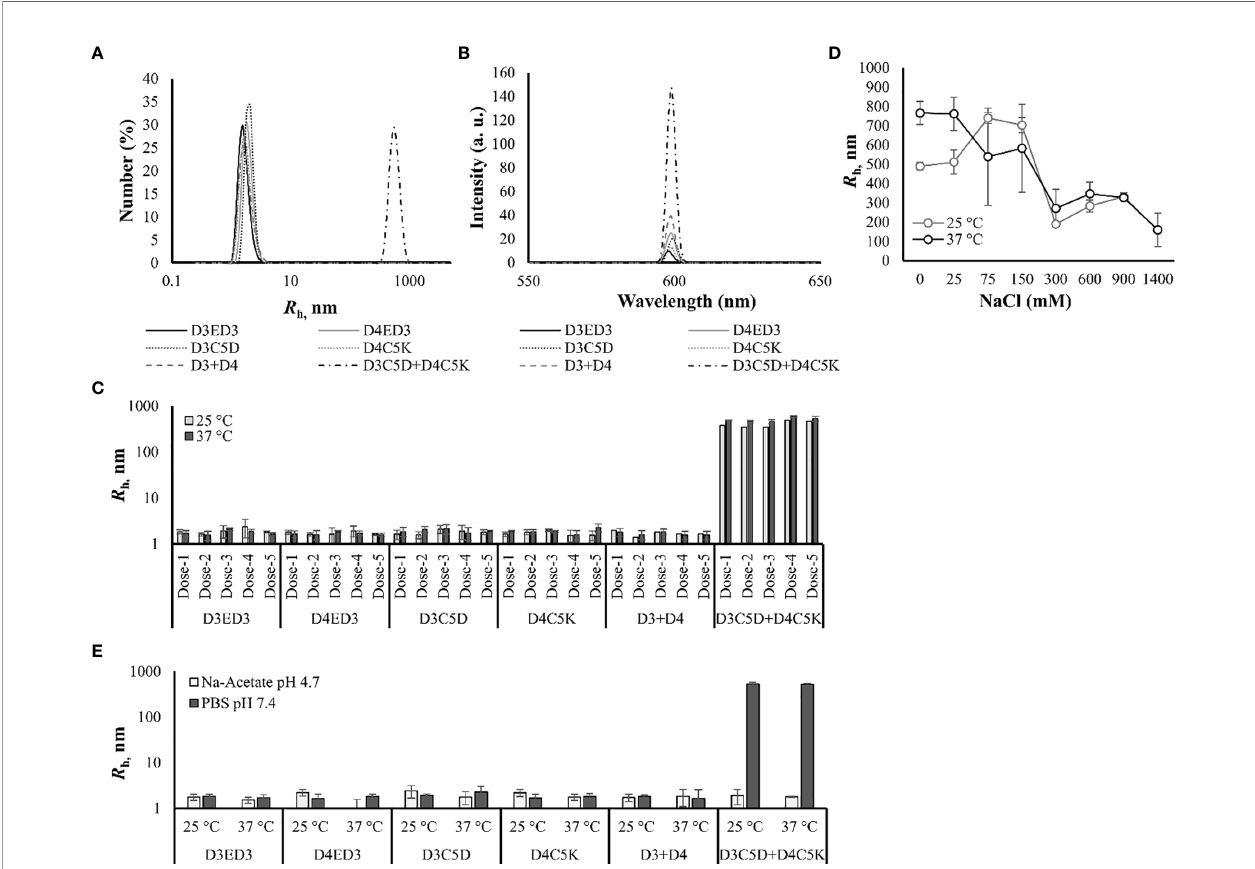
FIGURE 2 | Sub-visible aggregates ’ sizes measured by DLS and SLS. (A) DLS spectra of the size distribution number (%) at 37°C. (B) SLS spectra measured at 37°C. (C) Hydrodynamic radii of the tagged and untagged ED3s measured just before immunization from dose-1 to dose-4 at 25° and 37°C. (D) Salt-concentration [0-1400 mM] dependent hydrodynamic radius of D3C5D+D4C5K formulated in 10 mM PB, pH 7.0. (E) Hydrodynamic radii of D3ED3, D4ED3, D3C5D, D4C5K, D3+D4 and D3C5D+D4C5K when formulated in 10 mM Na-acetate buffer, pH 4.7 at 25° and 37°C. The R h were computed from DLS ’ s number spectra. Proteins were formulated at a fi nal concentration of 0.3 mg/mL in PBS pH, 7.4 for all measurements. Values are averaged over three independent measurements and three accumulations. Line symbols are explained within the